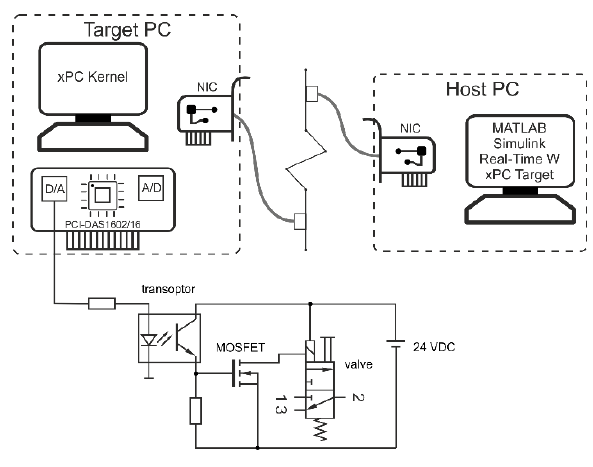
Fig. 6. Electronic system diagram.